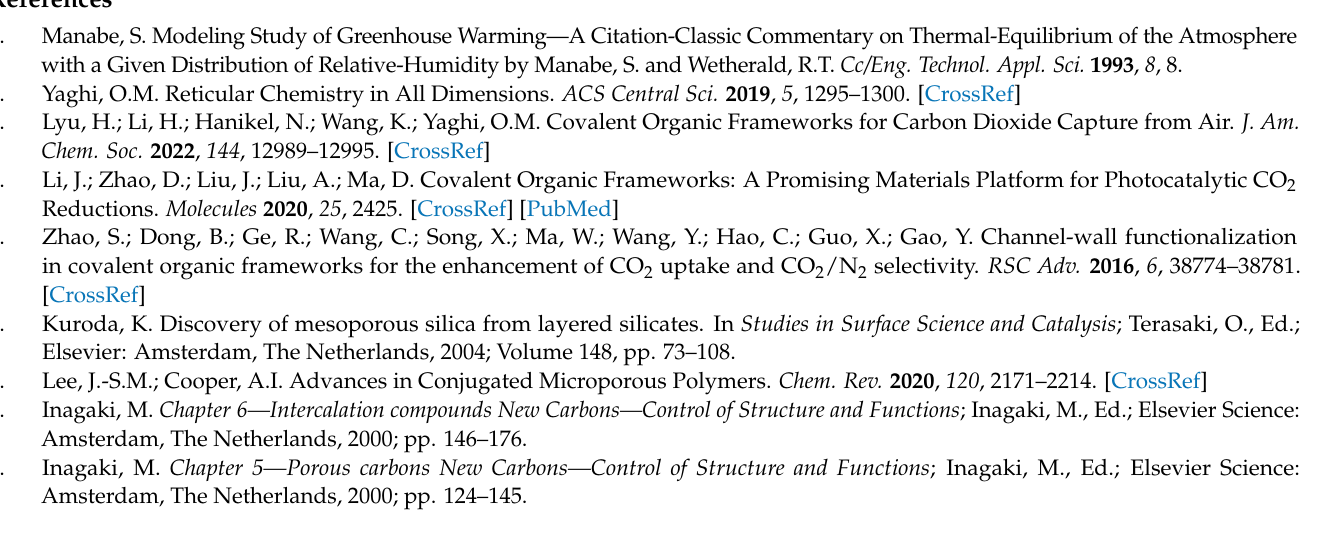
of fibers. Figure S6: Soot characterization (ST). Figure S7: Isosteric heats of adsorption. Figure S8: Carbon fibers grown with different